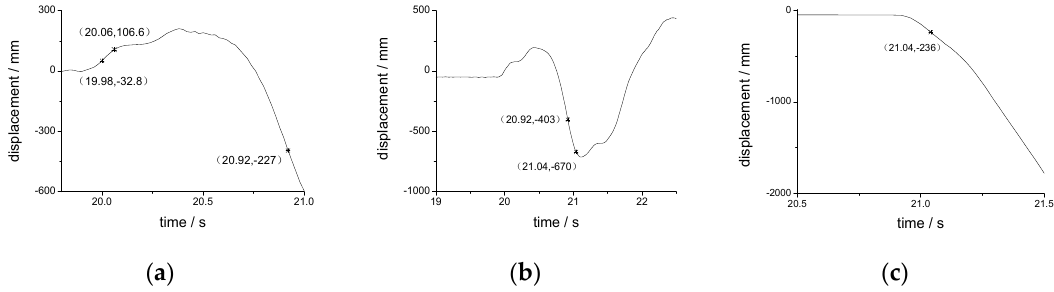
Figure 22. Displacement time history curve: ( a ) longitudinal displacement at the top of the middle pier; ( b ) relative longitudinal displacement of side pier and girder; ( c ) vertical displacement at the end of the girder.